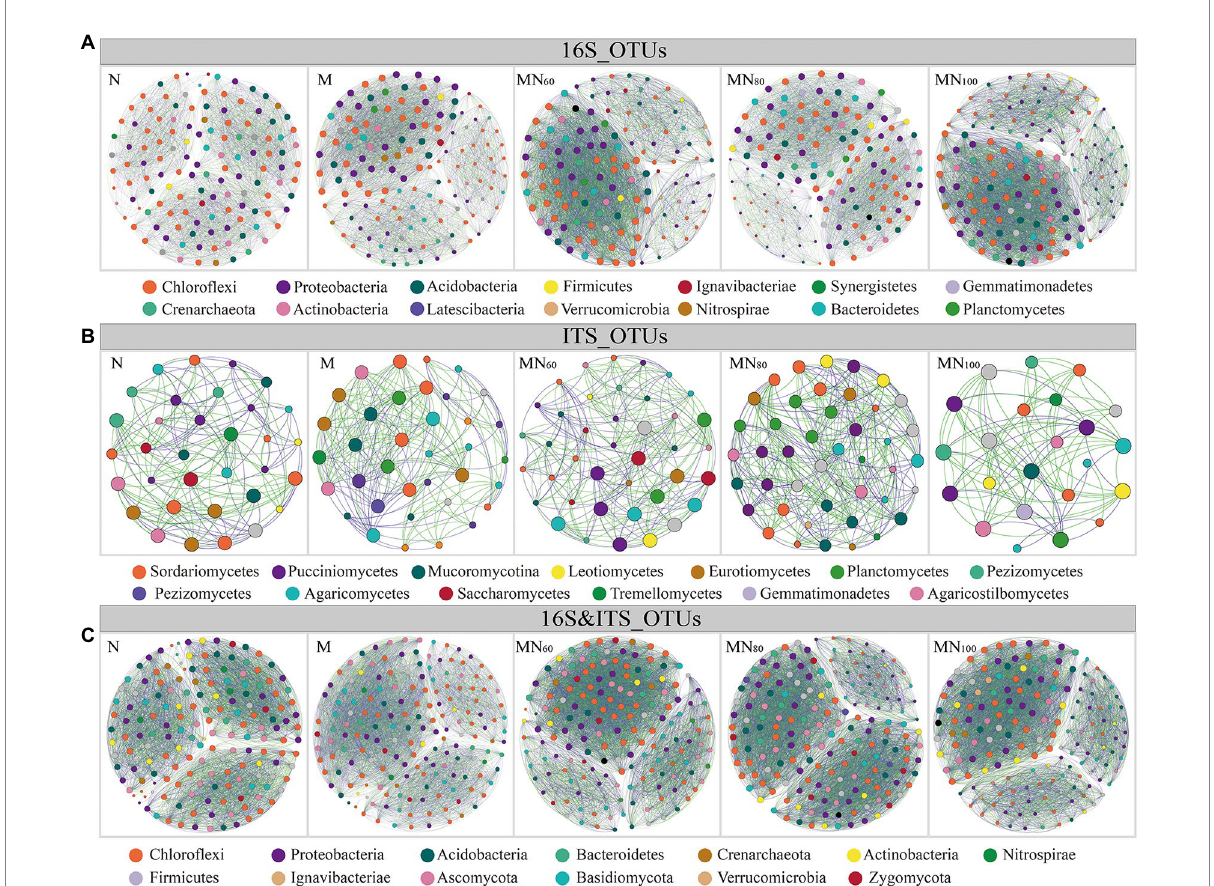
FIGURE 4 Network visualizes the interactions between soil operational taxonomic units (OTUs) in Karst paddy fields. Positive correlations are displayed in green and negative correlations were displayed in purple. The nodes are colored according to different types of species category. The size of each node is proportional to the betweenness centrality. A–C denote bacterial intra-group interactions, fungal intra-group interactions, and bacterial– fungal inter-group interactions,